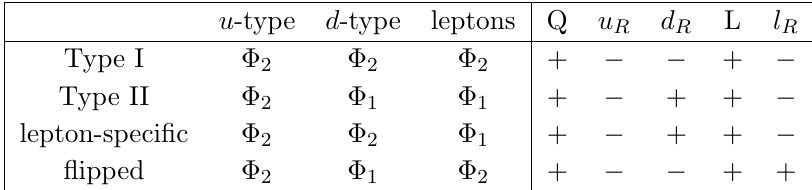
Table 1 . Left: de(cid:12)nition of the 2HDM types through the allowed couplings among fermions and Higgs doublets. Right: corresponding Z 2 parity assignments to the left-handed quark and lepton doublets, Q , L , and the right-handed singlets of the up-type and down-type quarks, u R and d R , and right-handed leptons l R